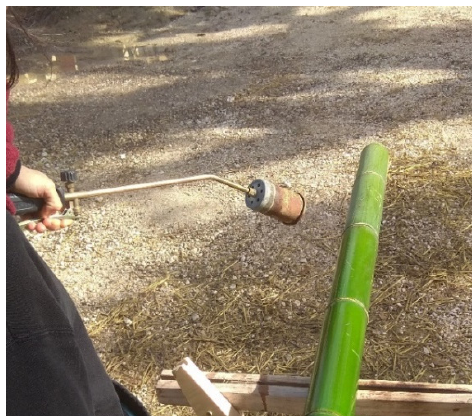
Figure 1. Flame treatment.